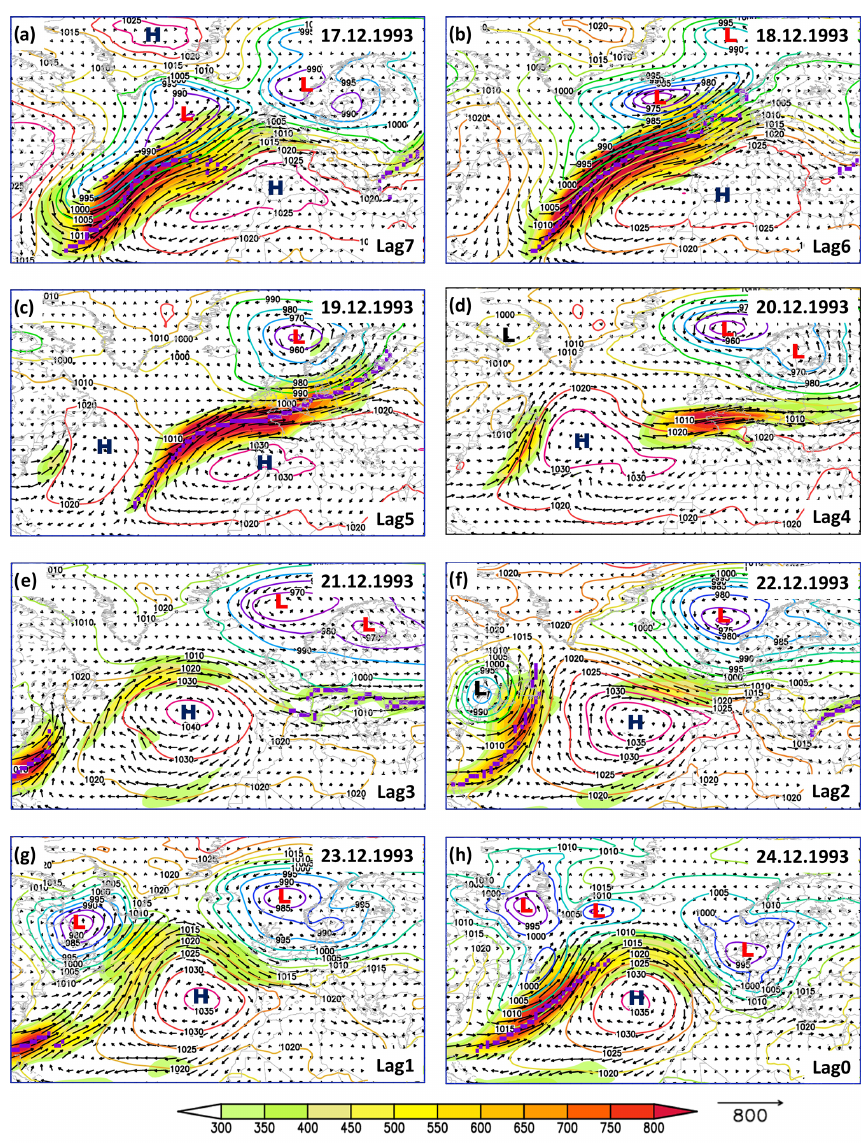
Figure 6. Daily sea level pressure (SLP; colored contour lines), magnitude of the integrated water vapor transport (IVT; shading), direction of the integrated water vapor transport (vectors) and location of the AR axis (magenta line) for different time lags (0–7d) for the 1993 flood event. Units: SLP (hPa) and IVT (kgs − 1 m − 1